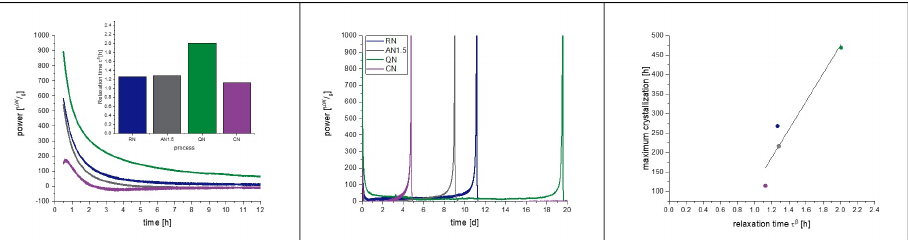
Figure 5. Placebo pre-tests at 40 °C to examine the correlation of crystallization with α-relaxation and the effect of the freezing step on the latter. The left picture presents a zoomed in area of the IMC measurement to focus on the relaxation curves, which are converted to a τ β -value. The middle graph shows the full view of the measurement including the crystallization of the samples. On the right, the correlation of relaxation time with crystallization maximum of the IMC curves is presented. The correlation coefficient of the fit is r 2 = 0.88. Random nucleation (blue), additional annealing step of 1.5 h (grey), quench cooling (green), controlled nucleation (purple).